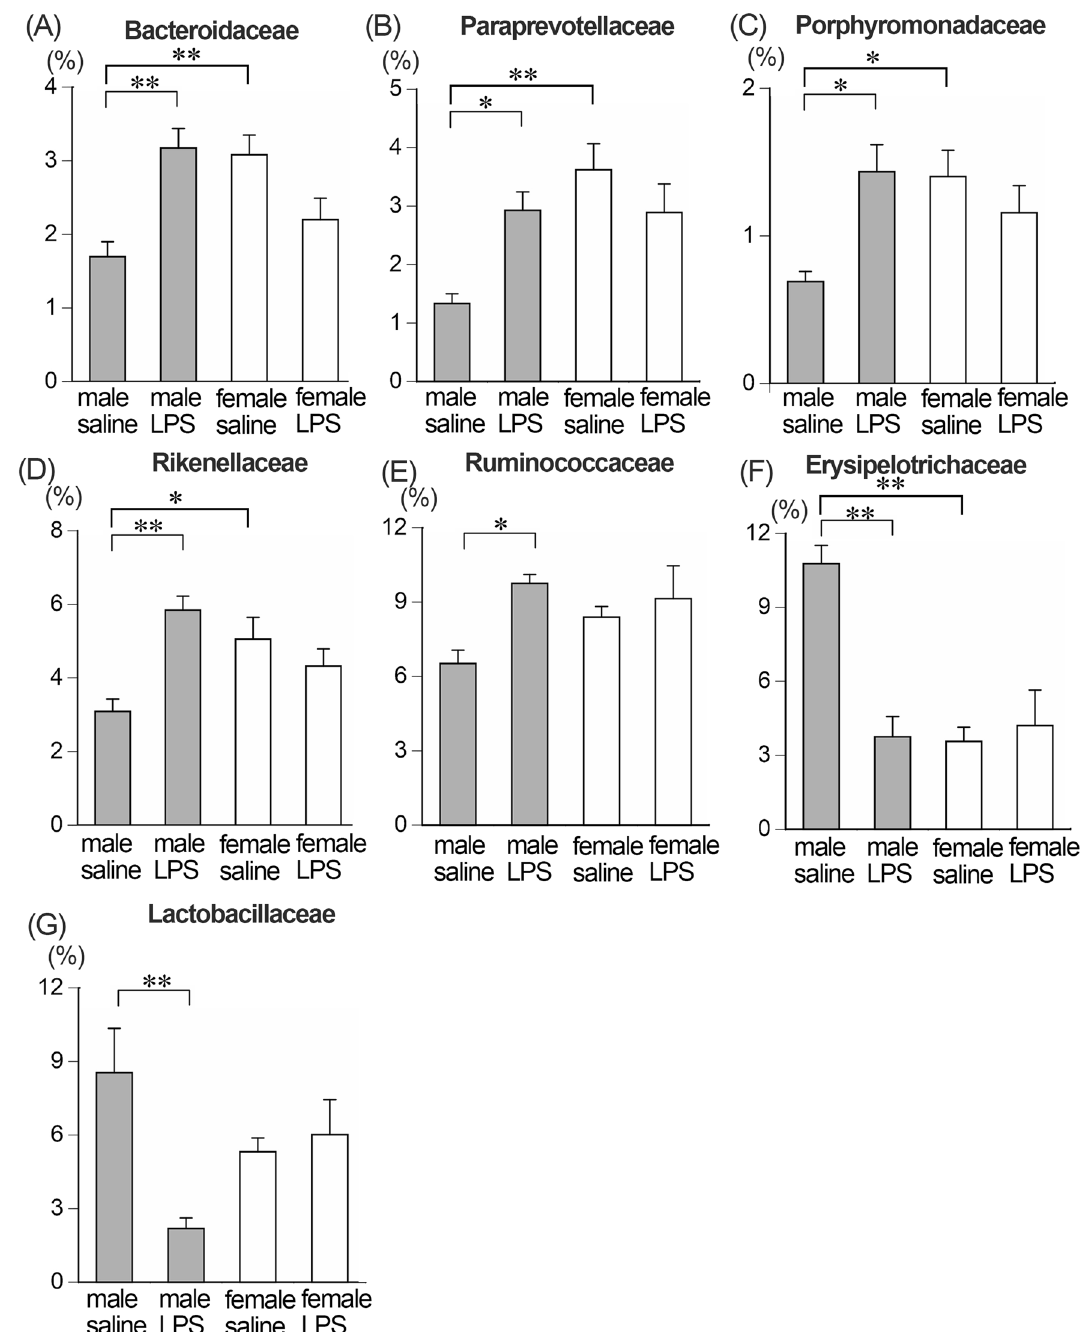
Figure 3. The relative abundance of gut microbiota at family level. Significant increases in the abundances of Bacteroidaceae ( A ), Paraprevotellaceae (k_Bacteria; p_Bacteroidetes; c_Bacteroidia; o_Bacteroidales; f_ Paraprevotellaceae) ( B ), Porphyromonadaceae ( C ), Rikenellaceae ( D ), and Ruminococcaceae ( E ) and decreases in Erysipelotrichaceae ( F ) and Lactobacillaceae ( G ) in male LPS-treated compared to male saline-treated mice were detected. * p < 0.05, ** p < 0.01. n = 5 for each